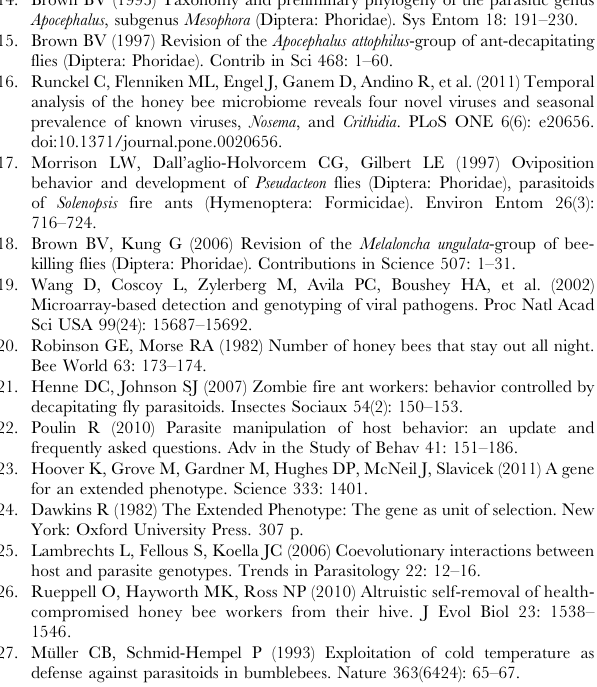
Table S2 Arthropod Pathogen Microarray results. Lo- cation codes are main study hive (HHH), stranded on landing near main hive (HHL), main hive enclosure (HHC), observation hive (OH), near feral hive on San Francisco State University campus (GYMA), feral hive near California Academy of Sciences (CAS), X’s indicate whether infected by phorids, Nosema ceranae , or deformed wing virus. Table S3 Rate of parasitism for Bombus vosnesenskii sampled from San Francisco, California locations from May to November